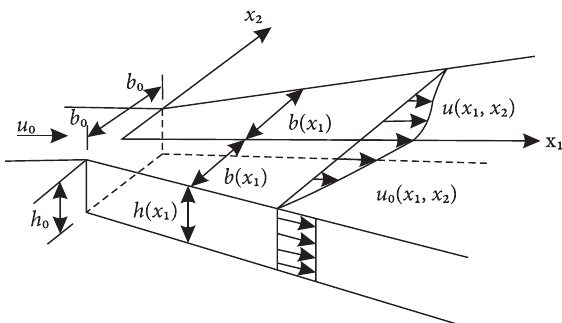
Figure 1. Schematic diagram of Channel (Wang, 1984); where, b is the half of initial width at section enlargement, 0 initial depth at section enlargement,